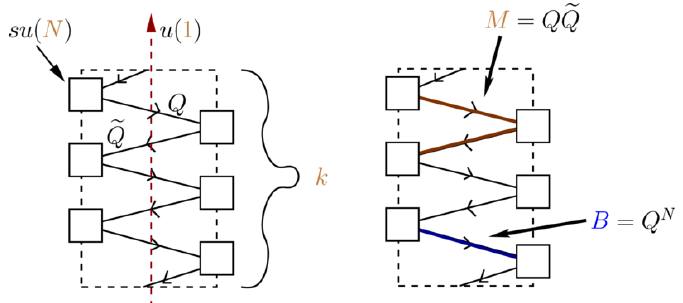
Figure 1 . The free trinion on the left and the mesonic and baryonic operators associated to punctures. The mesons are the bilinear combinations of Q and e Q denoted in brown in the picture. In the example here the meson is charged under the maximal puncture symmetry corresponding to the groups on the left side of the quiver and singlet under other puncture symmetries. Note that the meson operators in the free trinion are \mesons" of the maximal symmetry on the right in the usual sense of the word, that is are bilinears and singlets under that symmetry, but are operators we associate to the symmetry on the left under which they are charged in the bifundamental representation. The baryons are operators of the form Q N and are singlets of the maximal puncture symmetries while being charge under the minimal puncture abelian